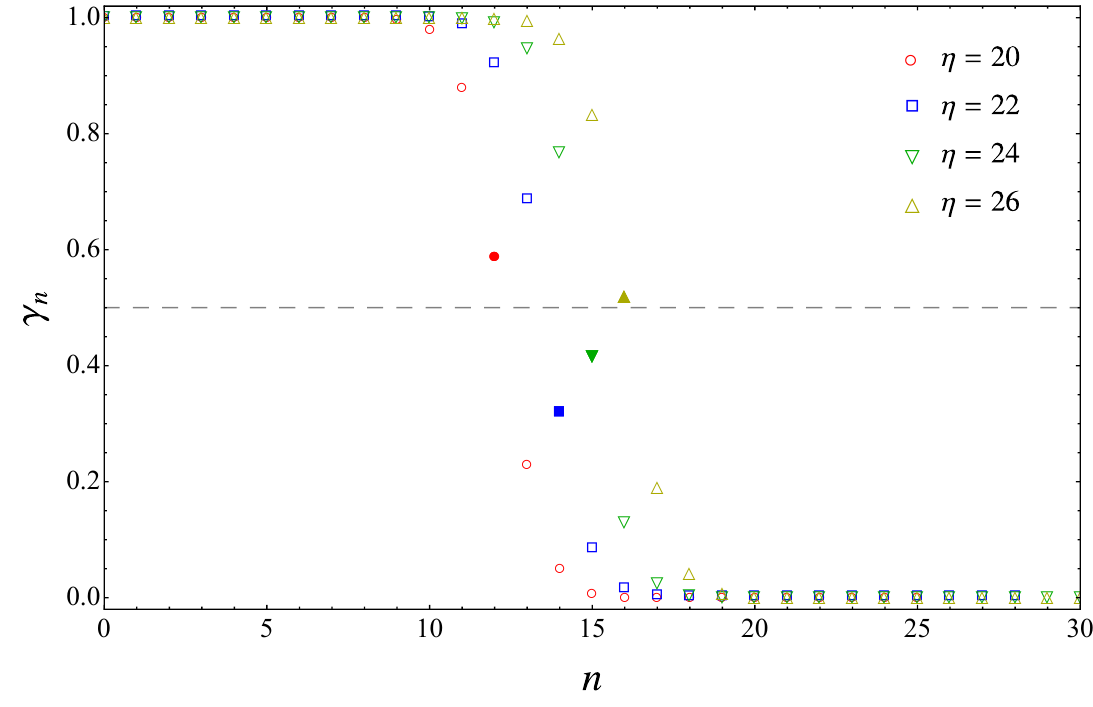
Figure 1. The first eigenvalues of the spectrum for the sine kernel (see (3.1) and (3.3)) for some values of the dimensionless parameter η . The sets I, II and III providing a natural partition of the spectrum can be easily recognised. For any η , the eigenvalue closest to 1 / 2 (full marker) provides the largest contribution to the entanglement entropies (4.1) and